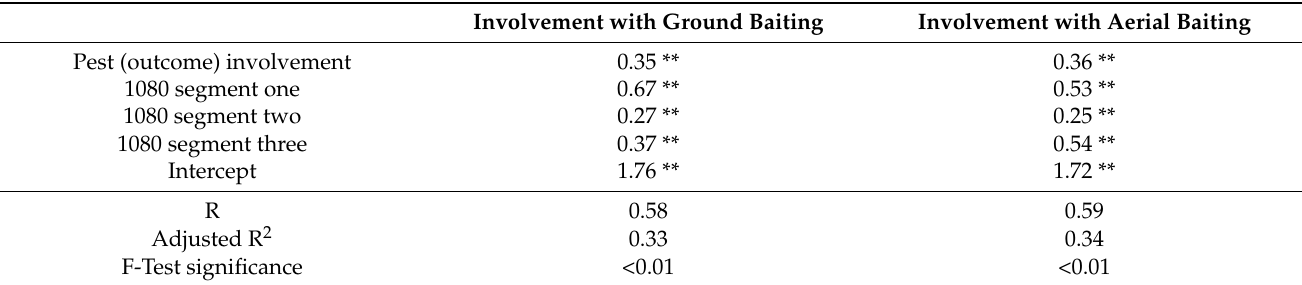
Table 7. Parameter estimates for involvement with ground and aerial baiting. Involvement with Ground Baiting